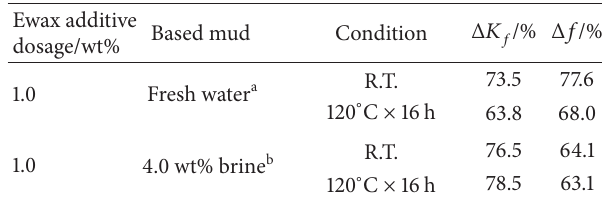
Table 1: Lubricity evaluation of Ewax in different based mud and at different